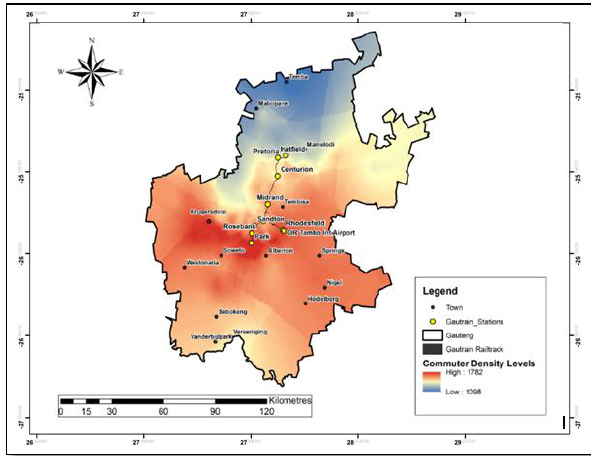
Figure 4: Maps showing the concentration levels of the tweets made in the Gauteng province.